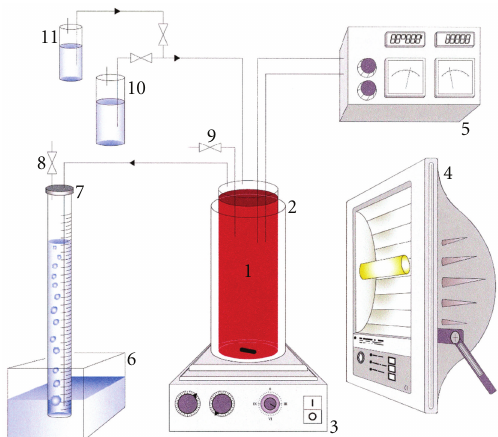
Figure 1: Schematic diagram of the cultural system. (1) Heat exchanger water bath; (2) photobioreactor; (3) magnetic stirrer; (4) lamp; (5) control unit; (6) saline solution basin; (7) graduated column trap; (8) gas sampling; (9) culture sampling; (10) MA stock solution; (11) glutamic acid stock